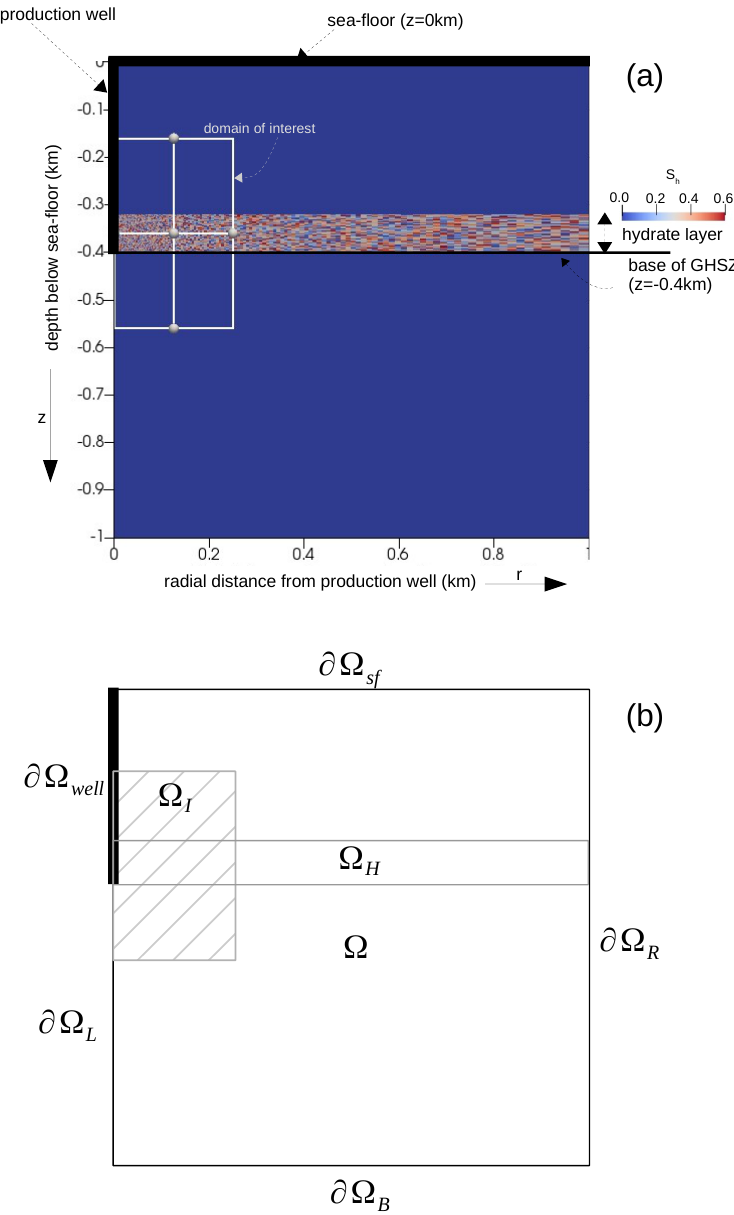
Figure 7. Problem setting for Example 2 (Section 4.2). Figure ( a ) highlights the essential features of the problem setting like the locations of the sea floor, the production well, the initial base of the GHSZ, and the initial hydrate distribution within the hydrate layer, and marks our domain of interest within the computational domain. Figure ( b ) identifies the relevant regions of the computational domain. Ω denotes the computational domain, Ω H ⊂ Ω denotes the hydrate layer, Ω I ⊂ Ω denotes the domain of interest, and Ω H ∩ Ω I (cid:54) = ∅ . ∂ Ω well denotes the production well boundary, while ∂ Ω L denotes the left boundary excluding the production well. ∂ Ω sf denotes the top boundary corresponding to the sea floor. ∂ Ω R and ∂ Ω B denote the right and the bottom boundaries,